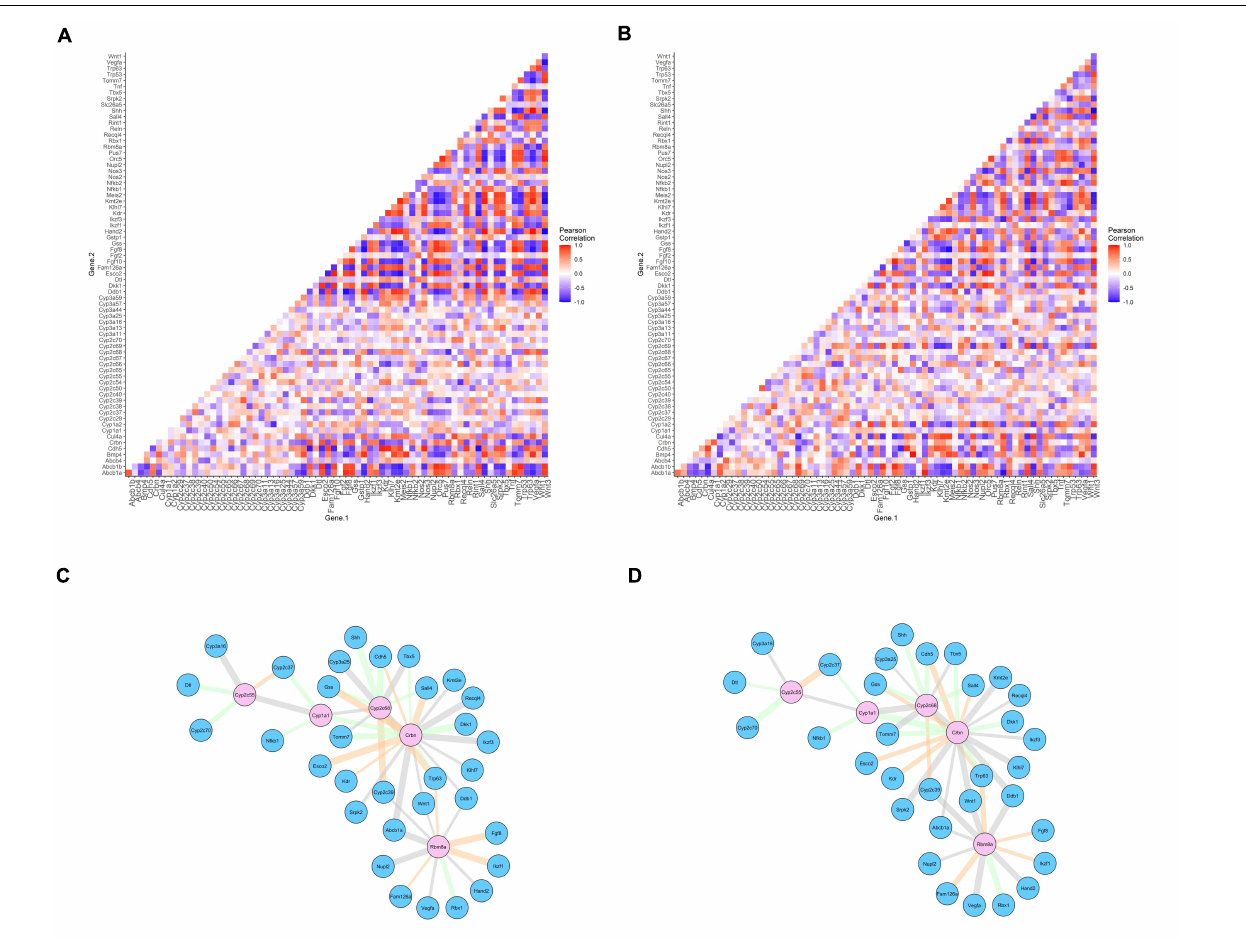
FIGURE 3 | Pearson correlation for differentially co-expressed gene pairs in controls (A) and thalidomide (B) exposed cells. Networks of differentially co-expressed gene pairs for controls (C) and thalidomide (D) exposed cells. Legend: (A,B) positive correlations represented in red; negative correlations in blue; absence of correlation in white. (C,D) genes that drive co-expression are represented in pink nodes; the other gene that composes the pair is represented in blue nodes. Edges’ thickness represents Pearson’s r correlation coefficient; gray edges = switched opposites ( r change > 1); orange edges = differentially signed ( r change < 1, but altering correlation from positive to negative, or contrariwise); green edges = same signed (correlation was changed, but maintained as positive or